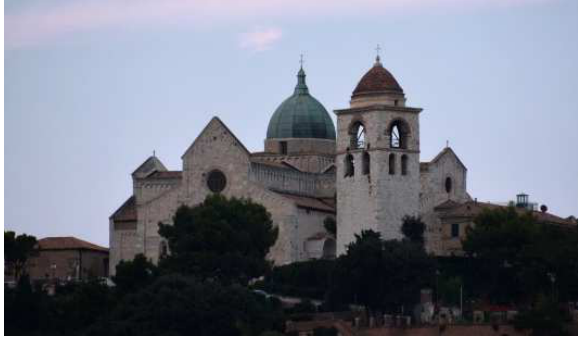
Figure 2 - Hill Metropolitan Cathedral-Basilica of Saint Cyriacus view from the Port of Ancona